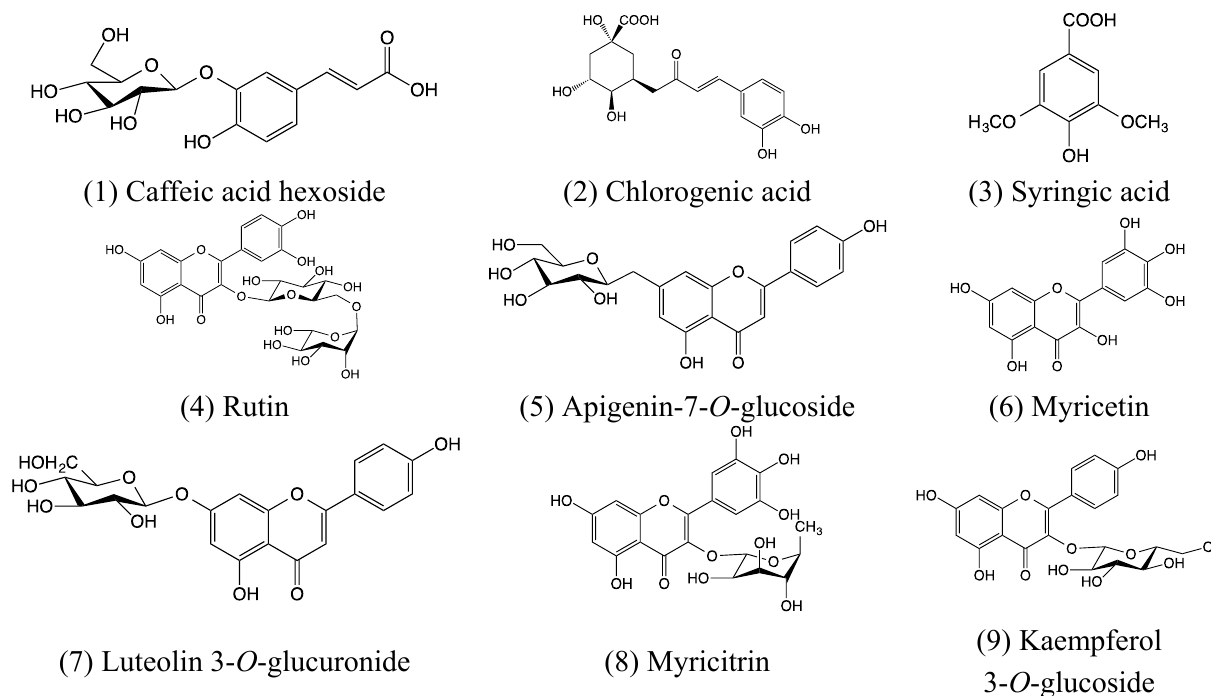
Figure 7. Structures determined for highbush blueberry using UV and MS/MS